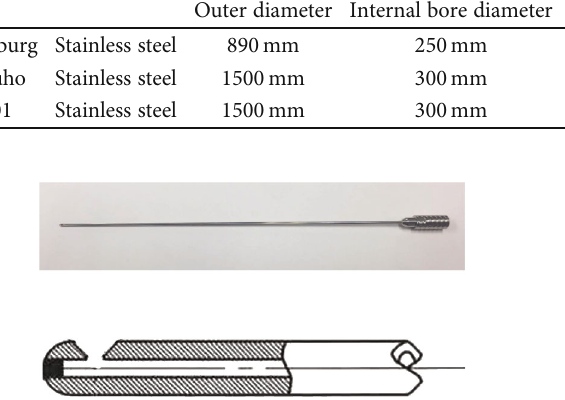
Figure 1: Photograph of the MK01 cannula and of the shape of the open ori fi ce. The distal side of the opening ori fi ce is curved just proximal to the equator line of the spherical tip so that the opening ori fi ce does not appear from the inserting trajectory